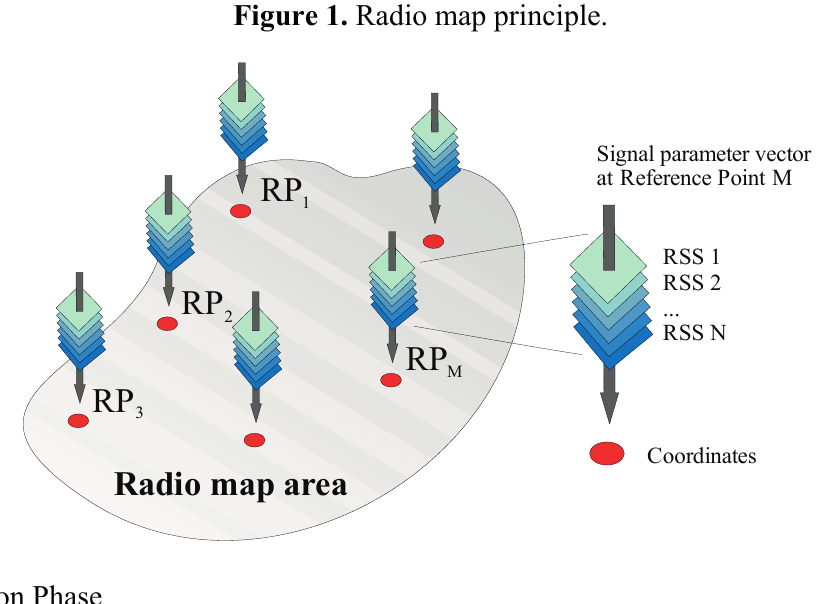
Figure 1. Radio map